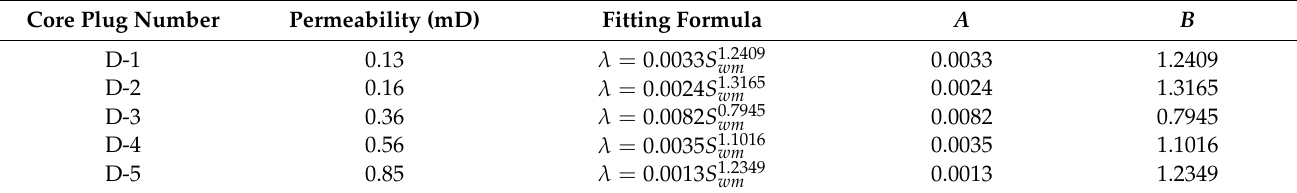
Table 5. The fitting formulas between TPG and S wm